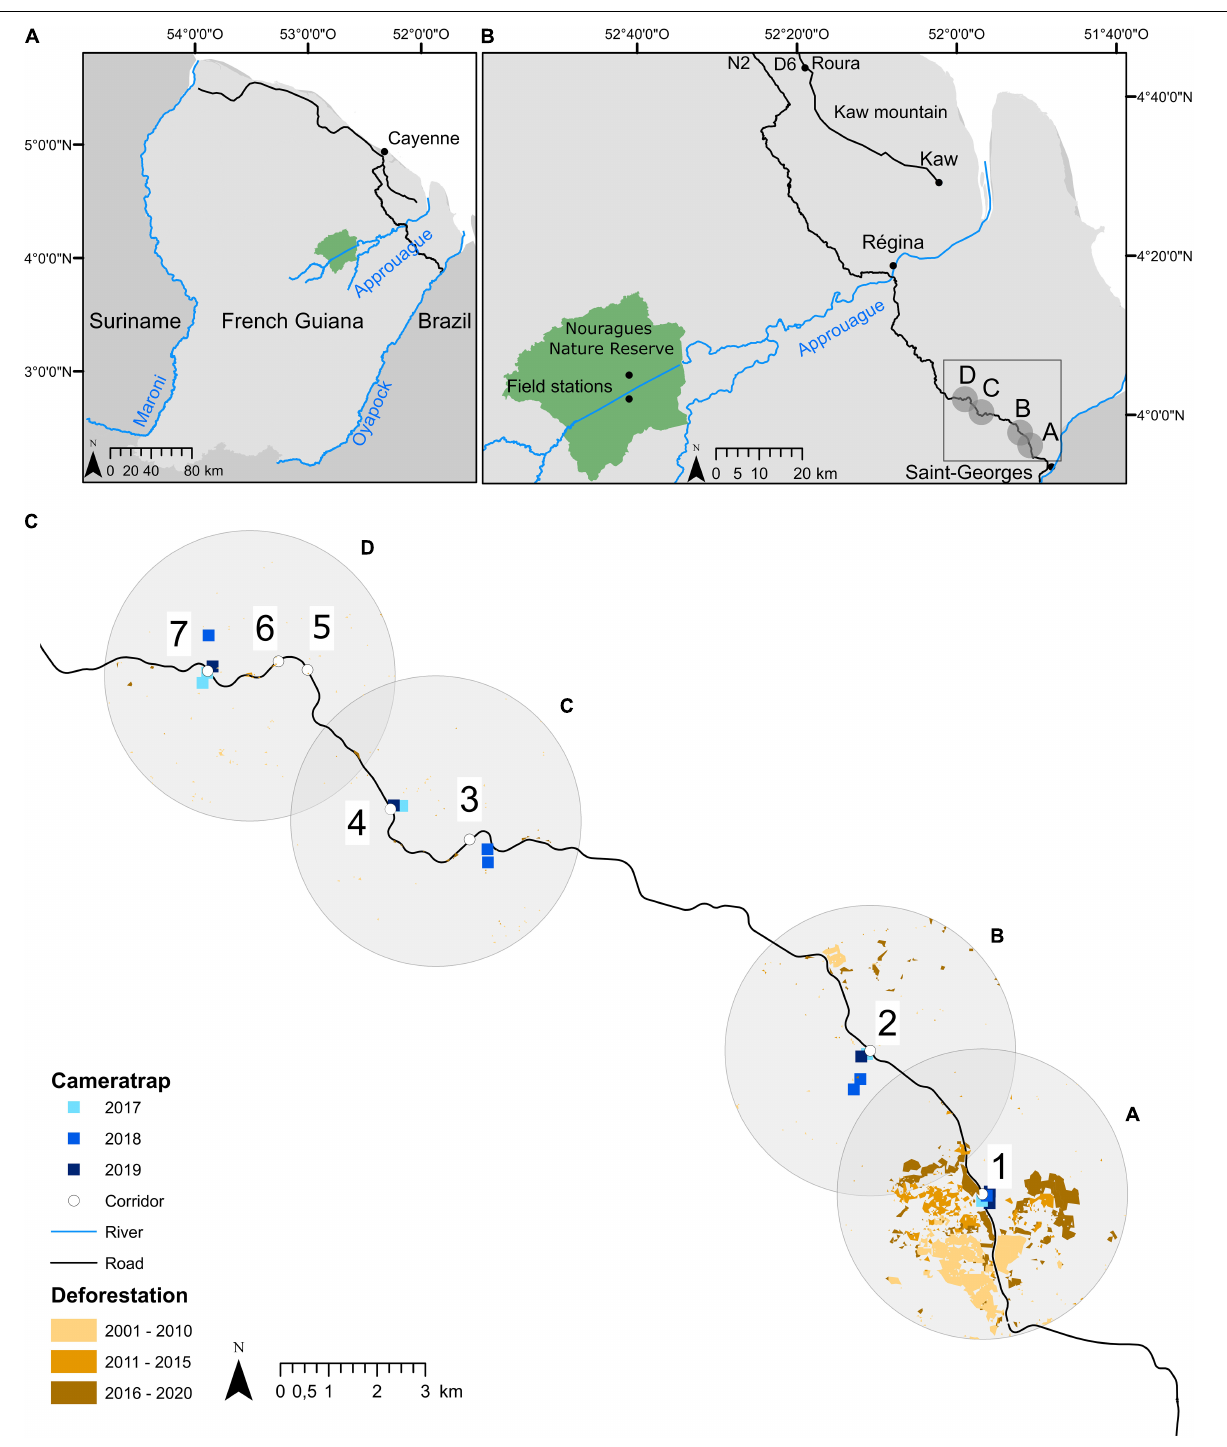
FIGURE 1 | (A) Map of French Guiana, in northern South America; (B) regional map showing the 3 study areas: Nouragues Nature Reserve, Montagne de Kaw, and Road “Nationale 2” (RN2) between Cayenne and Saint-Georges; (C) details of the location of the camera traps installed on the ground beneath fruiting Virola spp. and Manilkara spp. trees at the four forest patches along the new RN2 section between Régina and Saint-Georges. For the purpose of this study, study trees were located in forest patches surrounding the ecological corridors within 1 km from the road and up to ca. 33 km from the Oyapock River at Saint-Georges (the exact location of study trees is not shown for security